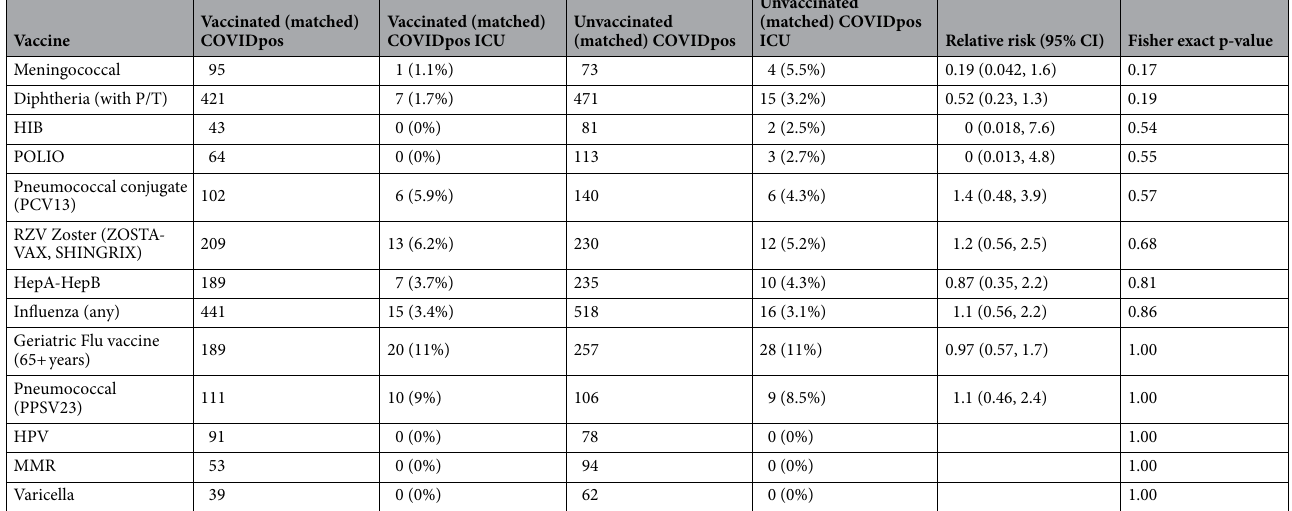
Table 11. Summary of COVID-19 ICU rates for vaccinated and unvaccinated propensity score matched cohorts (1 year time horizon). Table of COVID-19 ICU rates for vaccinated and unvaccinated (matched) cohorts for vaccines administered within 1 years prior to PCR testing. The columns are (1) Vaccine: Name of the vaccine, (2) Vaccinated (matched) COVIDpos: Number of patients who were COVID-positive among the vaccinated (matched) cohort and had ICU data, (3) Vaccinated (matched) COVIDpos ICU: Number of patients admitted to the ICU for COVID-19 among the vaccinated (matched) cohort, along with the percentage (taken over the vaccinated COVIDpos patients) in parentheses, (4) Unvaccinated (matched) COVIDpos: Number of patients who were COVID-positive among the unvaccinated (matched) cohort and had ICU data, (5) Unvaccinated (matched) COVIDpos ICU: Number of patients admitted to the ICU for COVID-19 among the unvaccinated (matched) cohort, along with the percentage (taken over unvaccinated COVIDpos patients) in parentheses, (6) Relative risk (95% CI): Relative risk of COVID-19-related ICU admission in the vaccinated (matched) cohort compared to the unvaccinated (matched) cohort, along with 95% confidence interval in parentheses, (7) Fisher exact